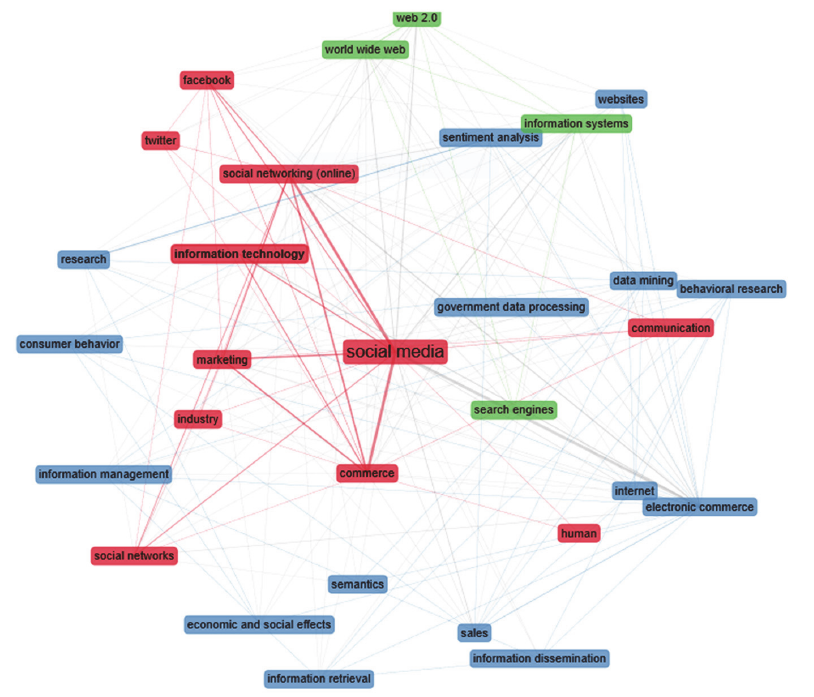
Fig. 5. Co-occurrence network (2005-2009)